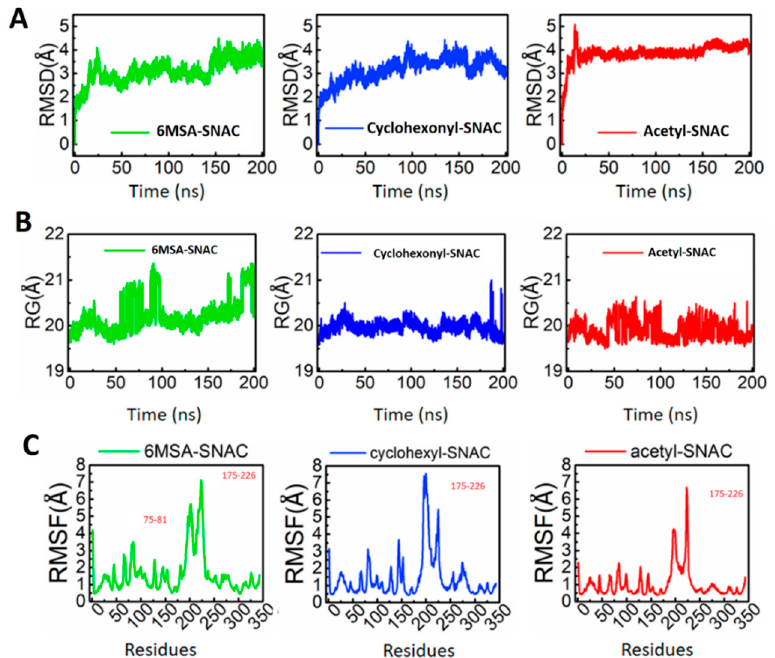
Figure 6. ( A ) Representation of the structural stability of the 6MSA-SNAC, cyclohexonyl-SNAC and acetyl-SNAC complexes, ( B ) The Rg graph of each complex. ( A ) 6MSA-SNAC; ( B ) acetyl-SNAC; ( C ) cyclohexonyl-SNAC. The x-axis shows the simulation time, while the y-axis shows Rg in Å. A 200 ns trajectory was used to calculate the compactness as Rg. ( C ) The RMSF graphs for each complex are shown in different colors. The x-axis shows the total number of residues while the y-axis shows RMSF in Å.